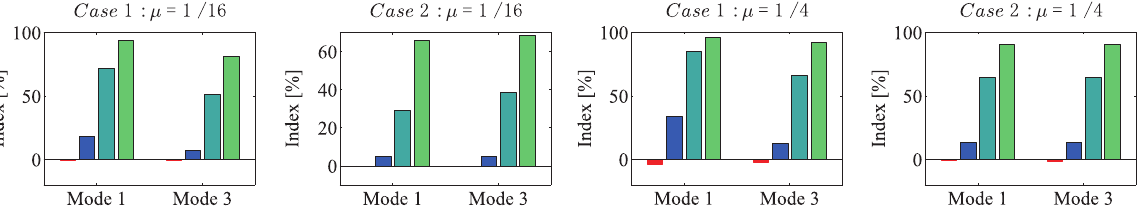
Fig. 9. Index variation in the first and second case for the first and third mode, calculated using frequency ( (cid:2) ) or active damping for the three ponderations ( (cid:2) : Q 1 , (cid:2) : Q 2 , (cid:2) : Q 3 ) and two cracks depth ( μ = 1 / 16 and μ = 1 / 4